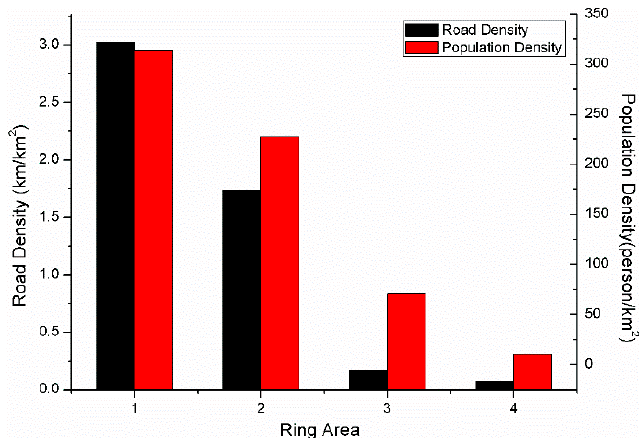
Figure 3. Density of road and population in each ring area.